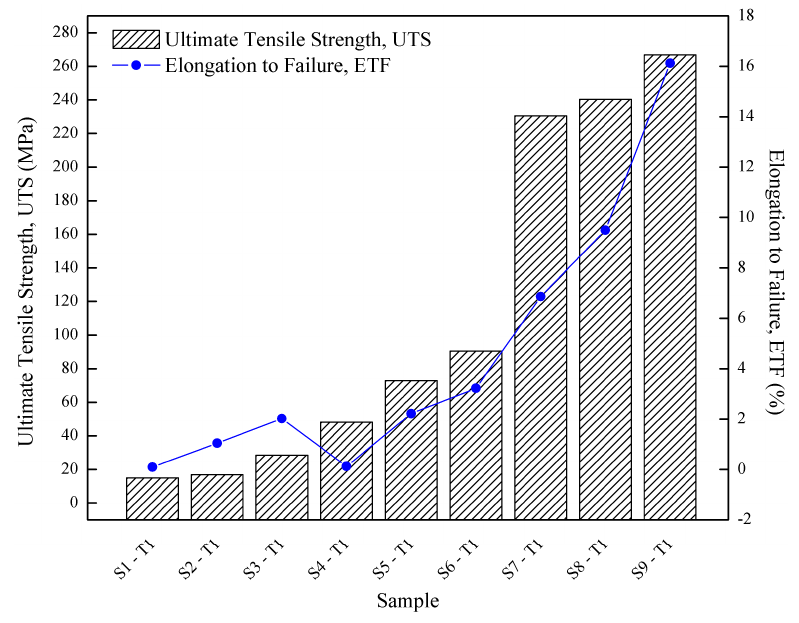
Figure 4. Tensile results of recycled specimen at different operating time and temperature.